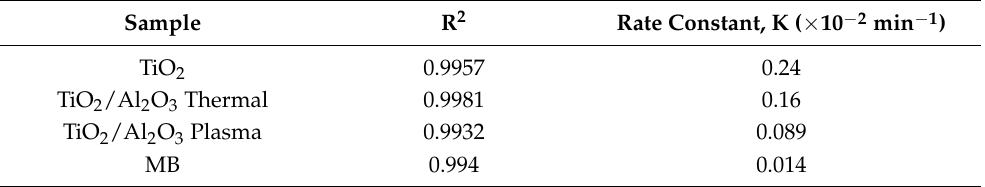
Table 3. The rate constant, K, and linear regression square, R 2 of the